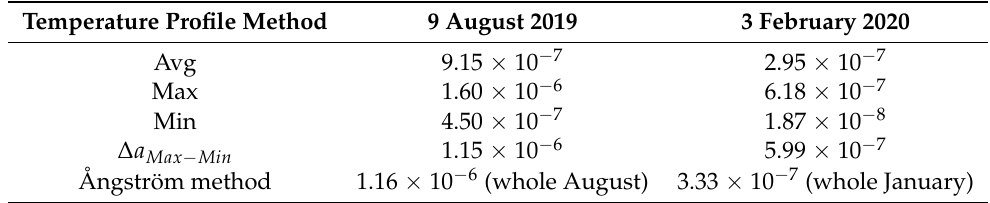
Table 5. Thermal diffusivity values for the considered days.